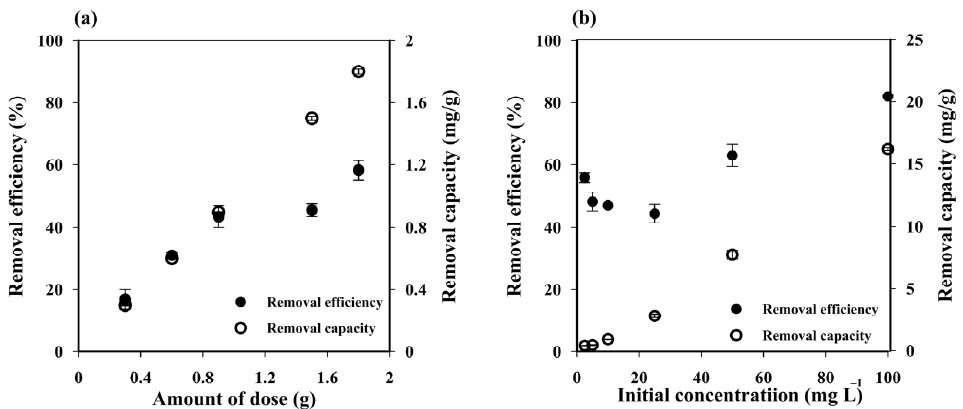
Figure 3. Influence of ( a ) cryogel dose and ( b ) initial methylene blue (MB) concentration on the MB removal efficiency and capacity of starch cryogel.